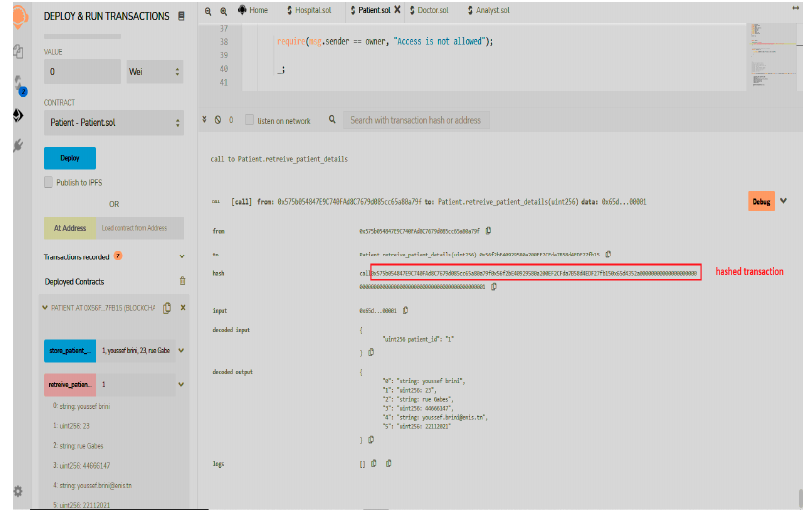
Figure 10. Patient implementation using Solidity.